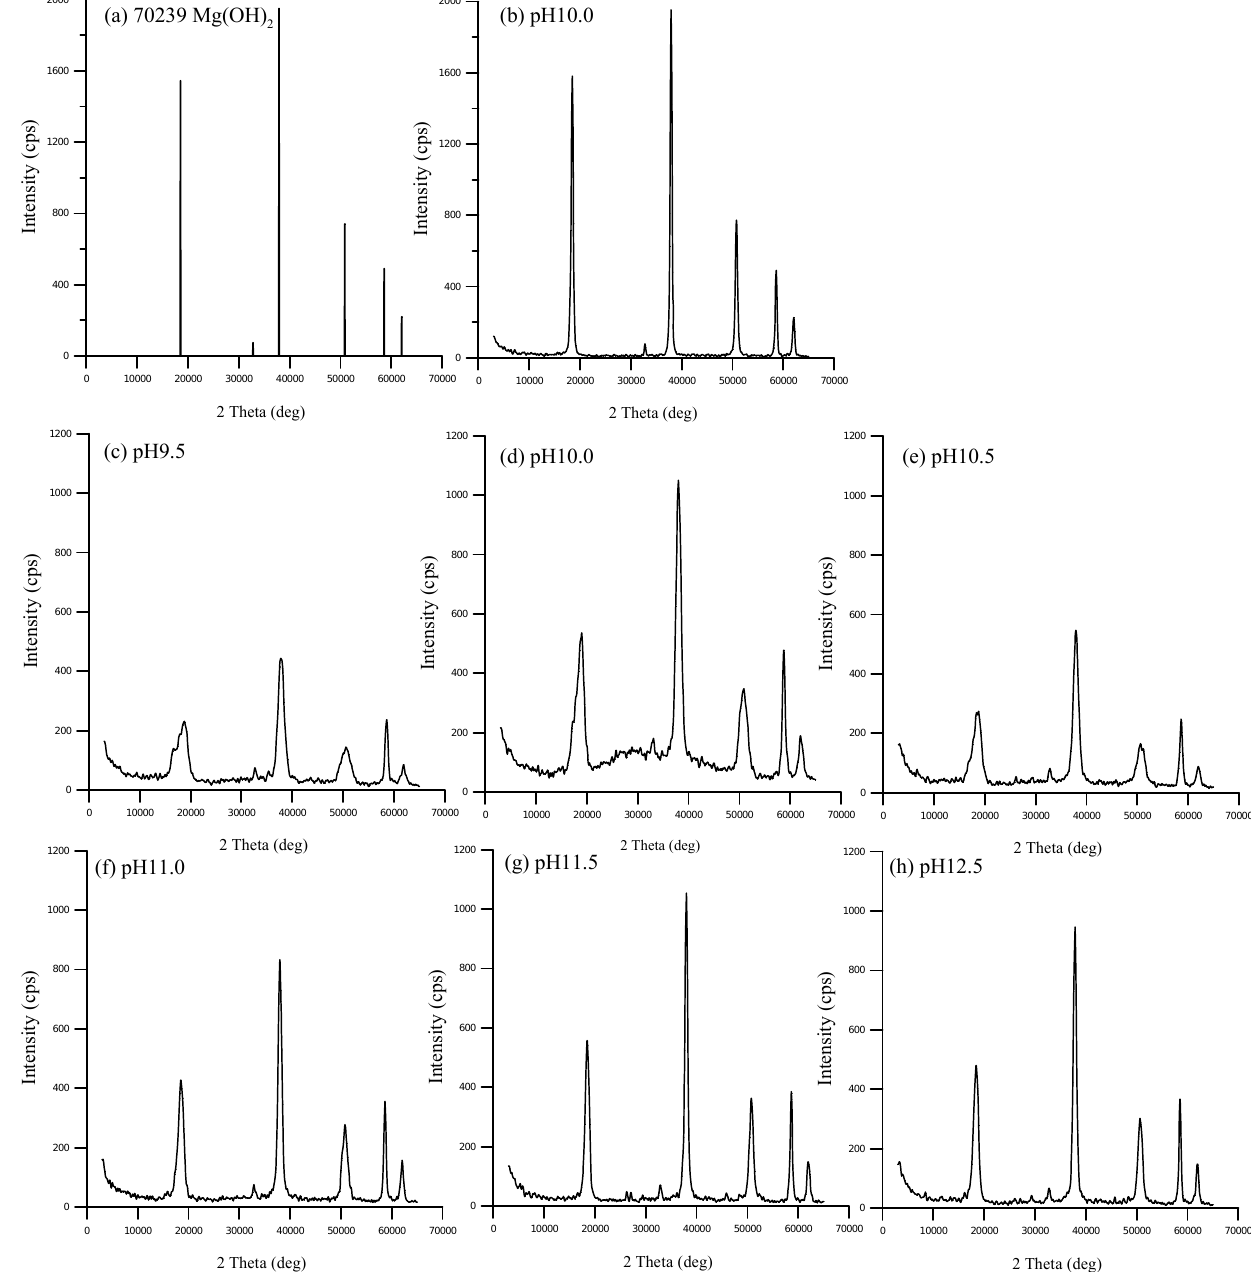
Fig. 7. X-Ray diffractogram of brucite deposited from artificial seawater at different pH values. (a) XRD of brucite standard, (b) XRD of brucite from boron-free artificial seawater at pH 10.0, (c)–(h) XRD of brucite in our experiments. The brucite peak in our samples is clear compared with brucite standard (Fig. 7a).